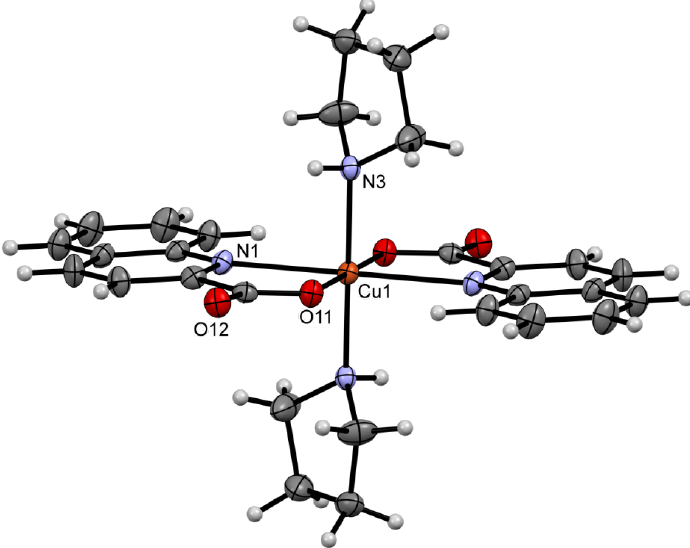
Figure 3. ORTEP drawing of one complex molecule in [Cu(quin) 2 (pyro) 2 ] ( 2 ). Displacement ellipsoids are drawn at the 50% probability level. Hydrogen atoms are shown as spheres of arbitrary radii.